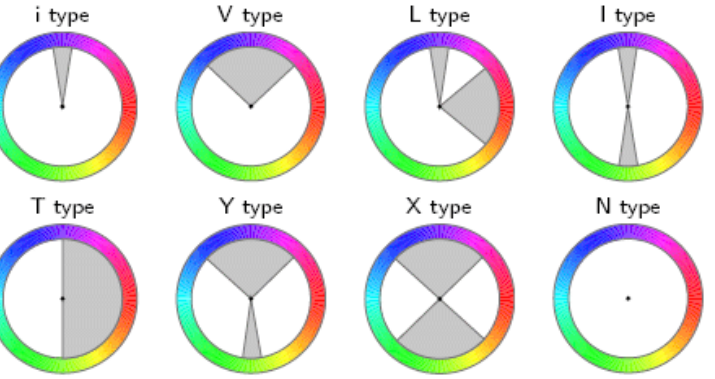
Figure 2. Eight harmonic types defined over the hue channel of the HSV color space proposed by Matsuda